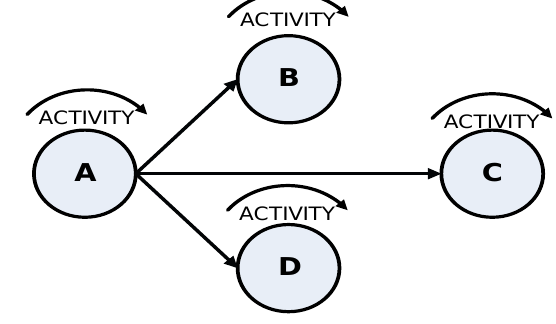
Figure 1. Network diagram